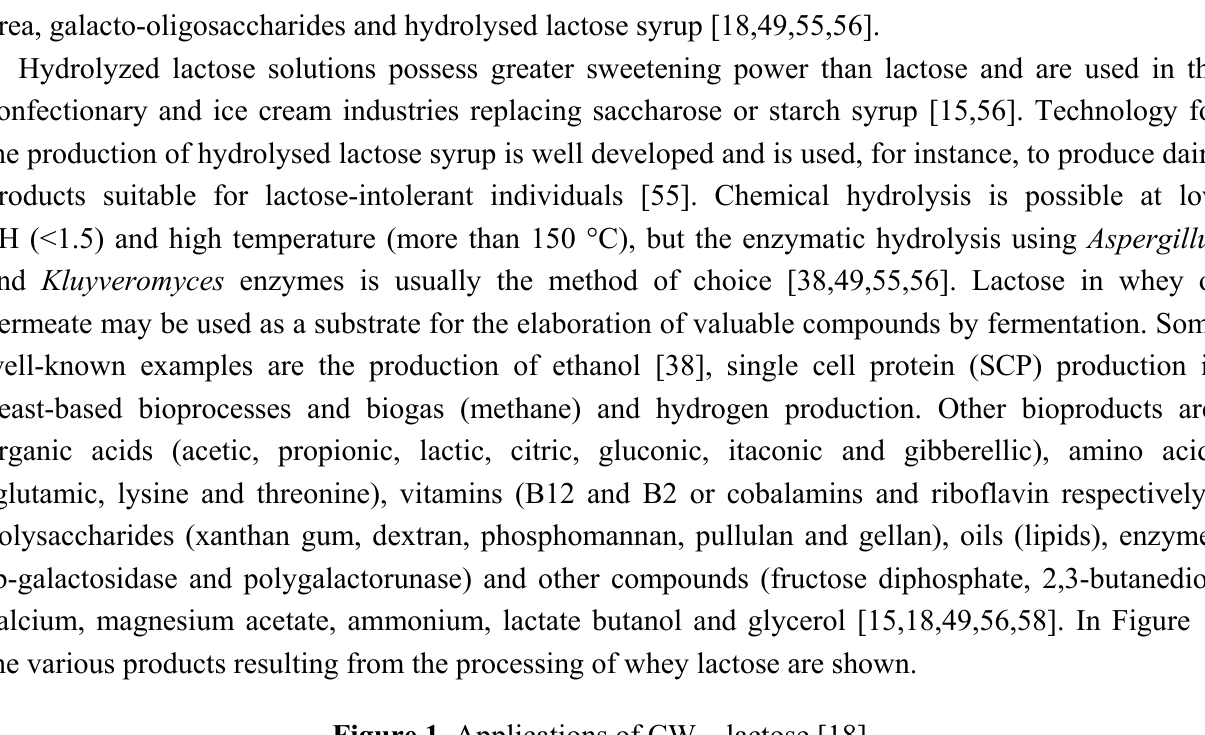
Figure 1. Applications of CW—lactose [18].